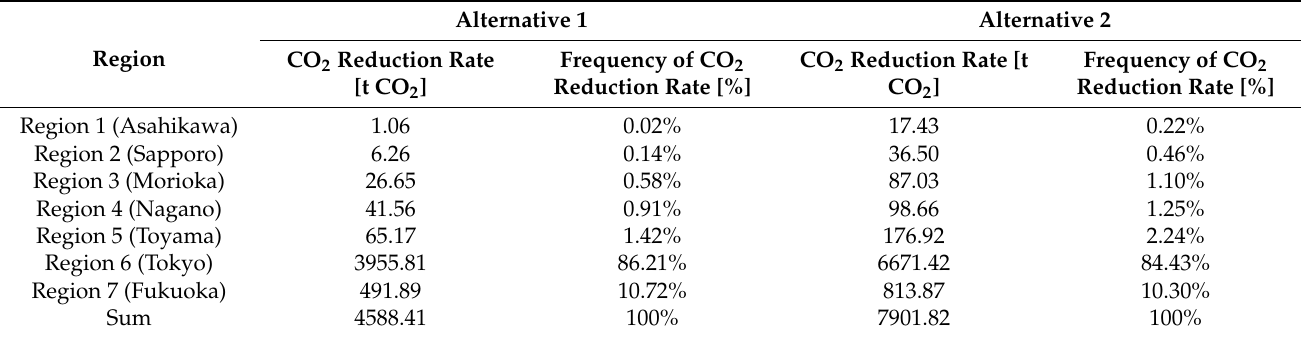
Table 6. CO 2 reduction rate according to alternative window